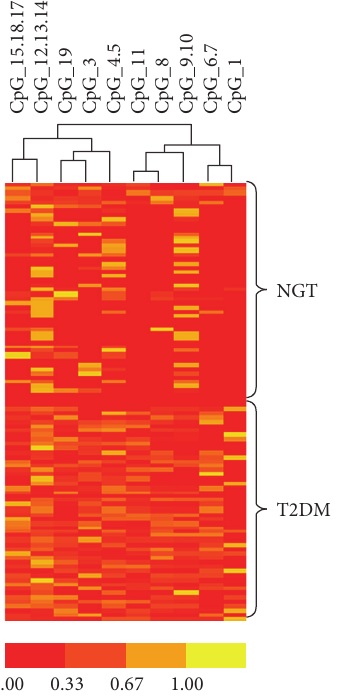
Figure 3: Hierarchical clustering of FOSL2 methylation between NGT and T2DM groups was measured by MassARRAY analysis. Each row reveals a subject. Each column reveals a CpG unit. Color coding represents the methylation level; yellow presents 100% and red 0%.